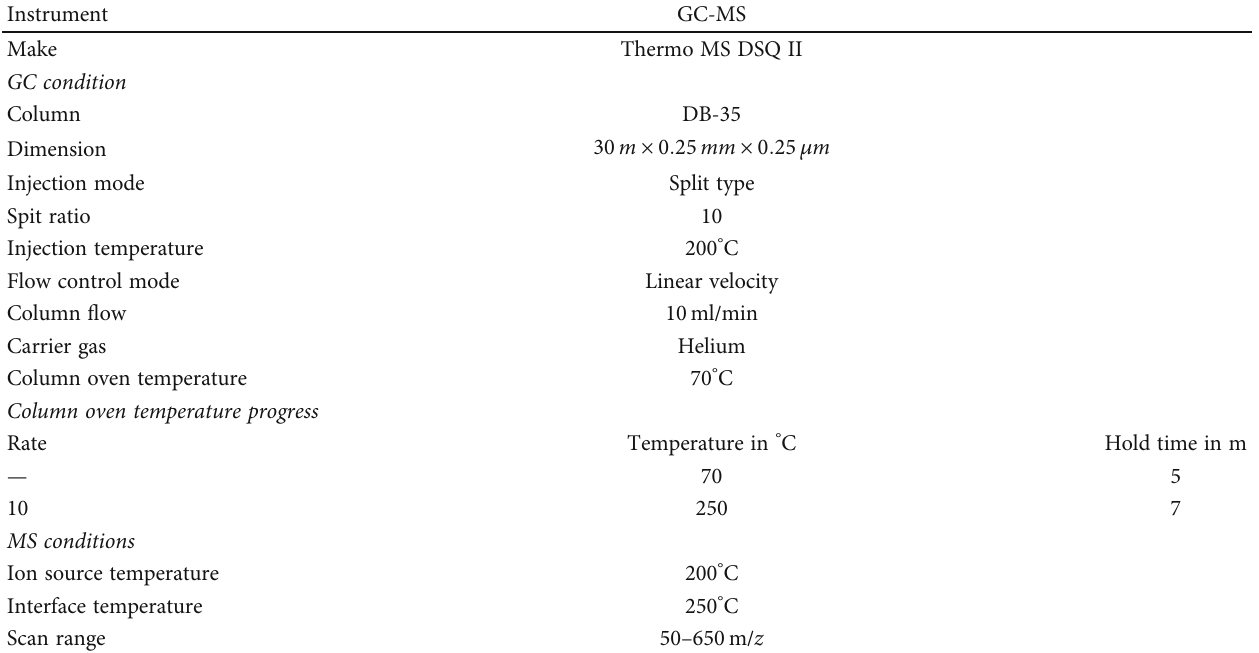
Table 2: GC-MS condition.